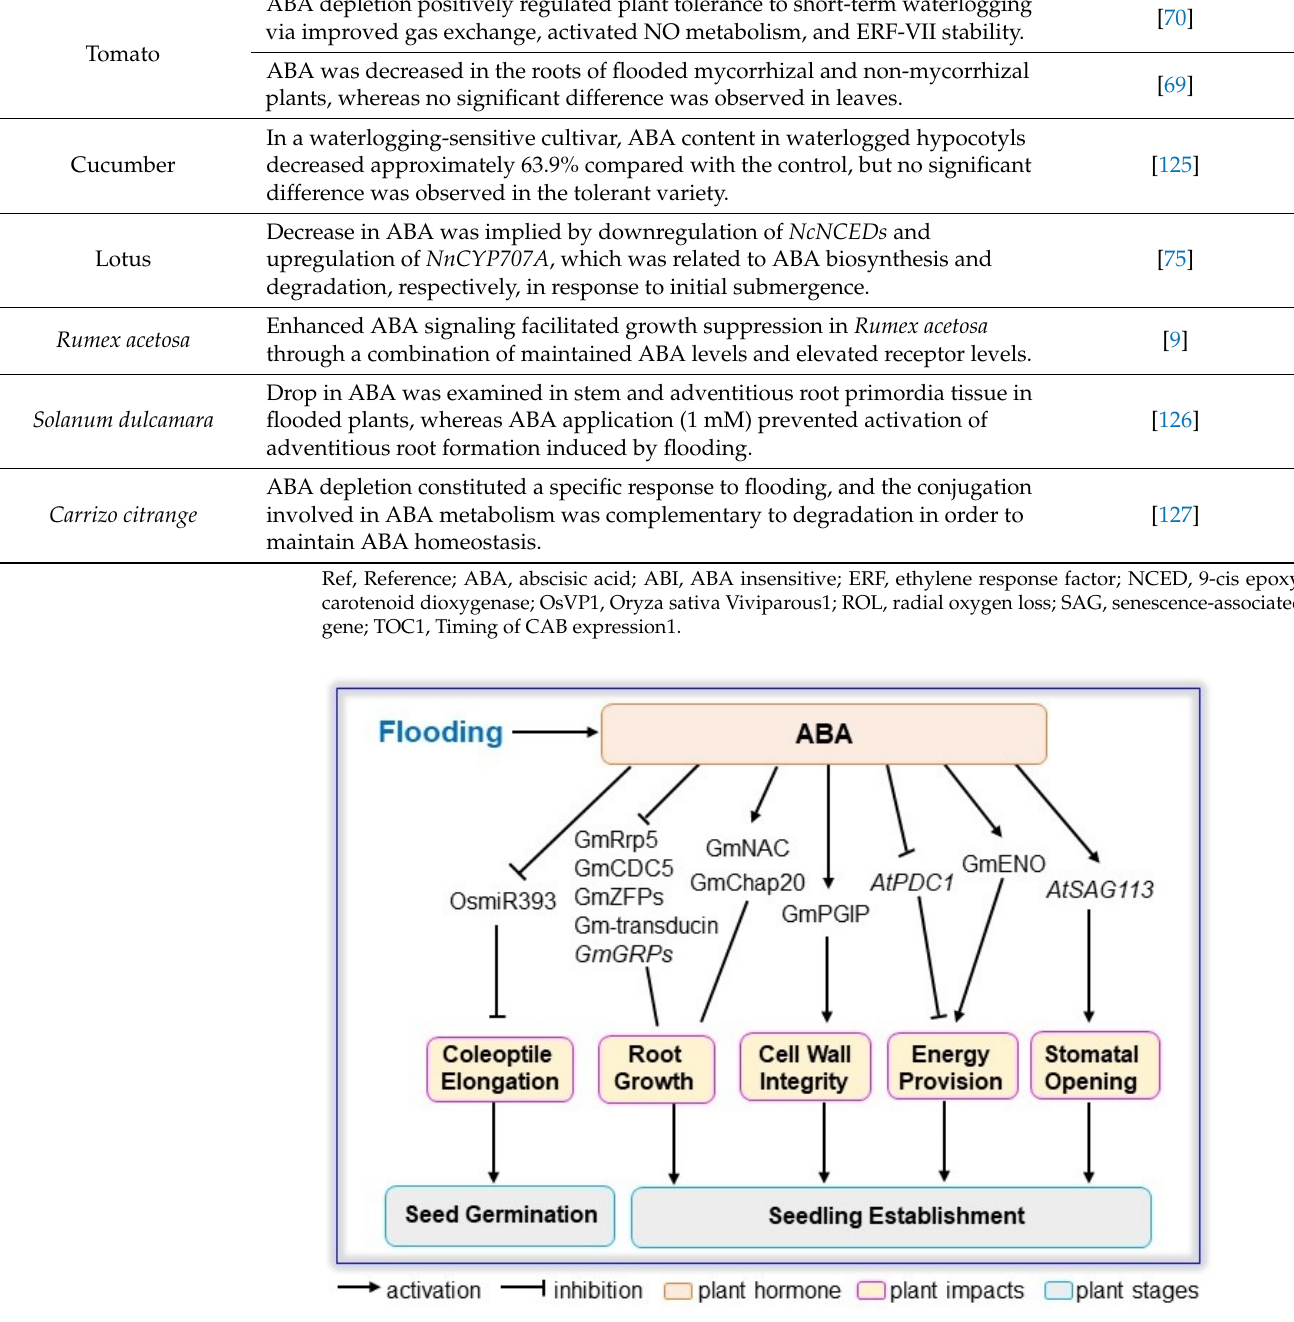
Figure 2. ABA signaling involved in plant response to flooding stress. Flooding alters ABA content with different accumulation patterns. The impact of exogenous ABA on flooded plants during seed germination and seedling establishment are summarized based on reported genes and